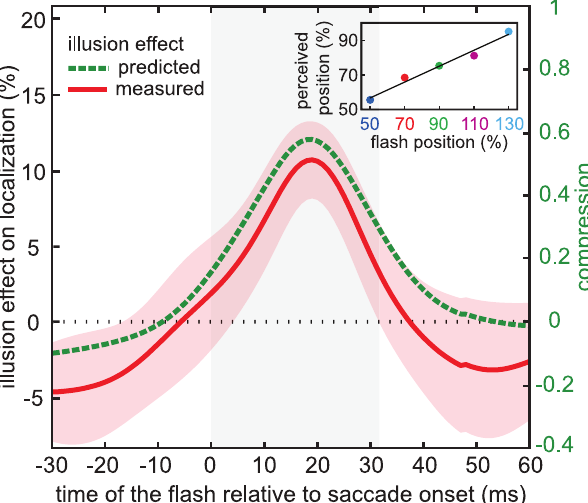
Figure 5. How localization depends on the illusion’s influence on the saccade. The red curve shows the average difference in localization between the two configurations of the figure (red trans- parent area: standard error across participants; grey area: average saccade duration) expressed as a percentage of shaft length (left axis). To predict the effect of the illusion on mislocalization, we multiplied the compression by the magnitude of the effect of the illusion on saccade amplitude (21%). The green curve shows this prediction as a function of the time of the flash. The vertical scale on the right gives the raw compression values on which this prediction is based. The inset at the upper right shows an example of how the compression was determined for each time (20 ms after saccade onset in this example). It shows the value of the mislocalization curve for each flash location at the time in question, with the best linear fit to these values (slope = a). Compression is defined as 1–a. (Note that for a compression of 1, the predicted illusion effect on localization would be 21%, because for complete compression the difference in localization would equal the difference in saccade